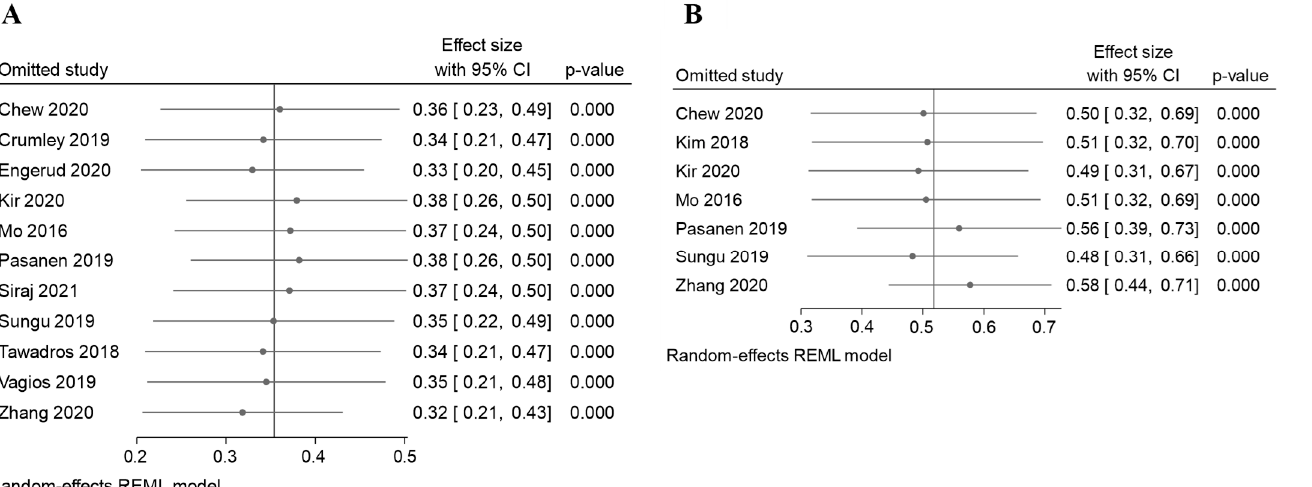
Figure 7. The Begg’s funnel plot of the PD-L1 proportion for the ( A ) TCs and ( B ) ICs. Side blue line indicates 95% confidence interval, middle blue line is the overall effect, and orange dots represent each individual study.